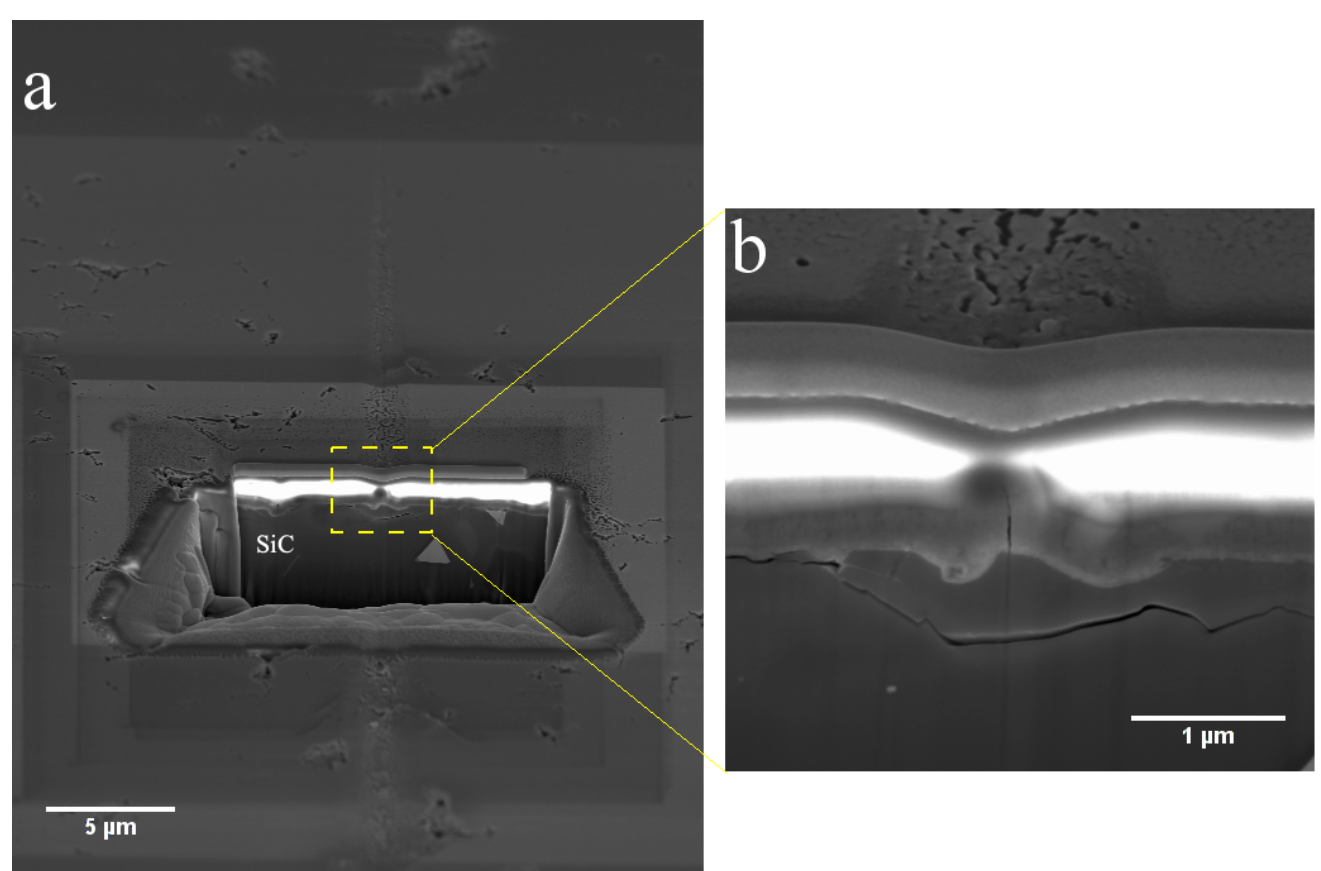
Figure 3. ( a ) Cross section performed using FIB at the midpoint of the scratch, i.e., at P max = 25 mN - l max =25 µm. ( b ) Higher magnification image focused on the center of the track.